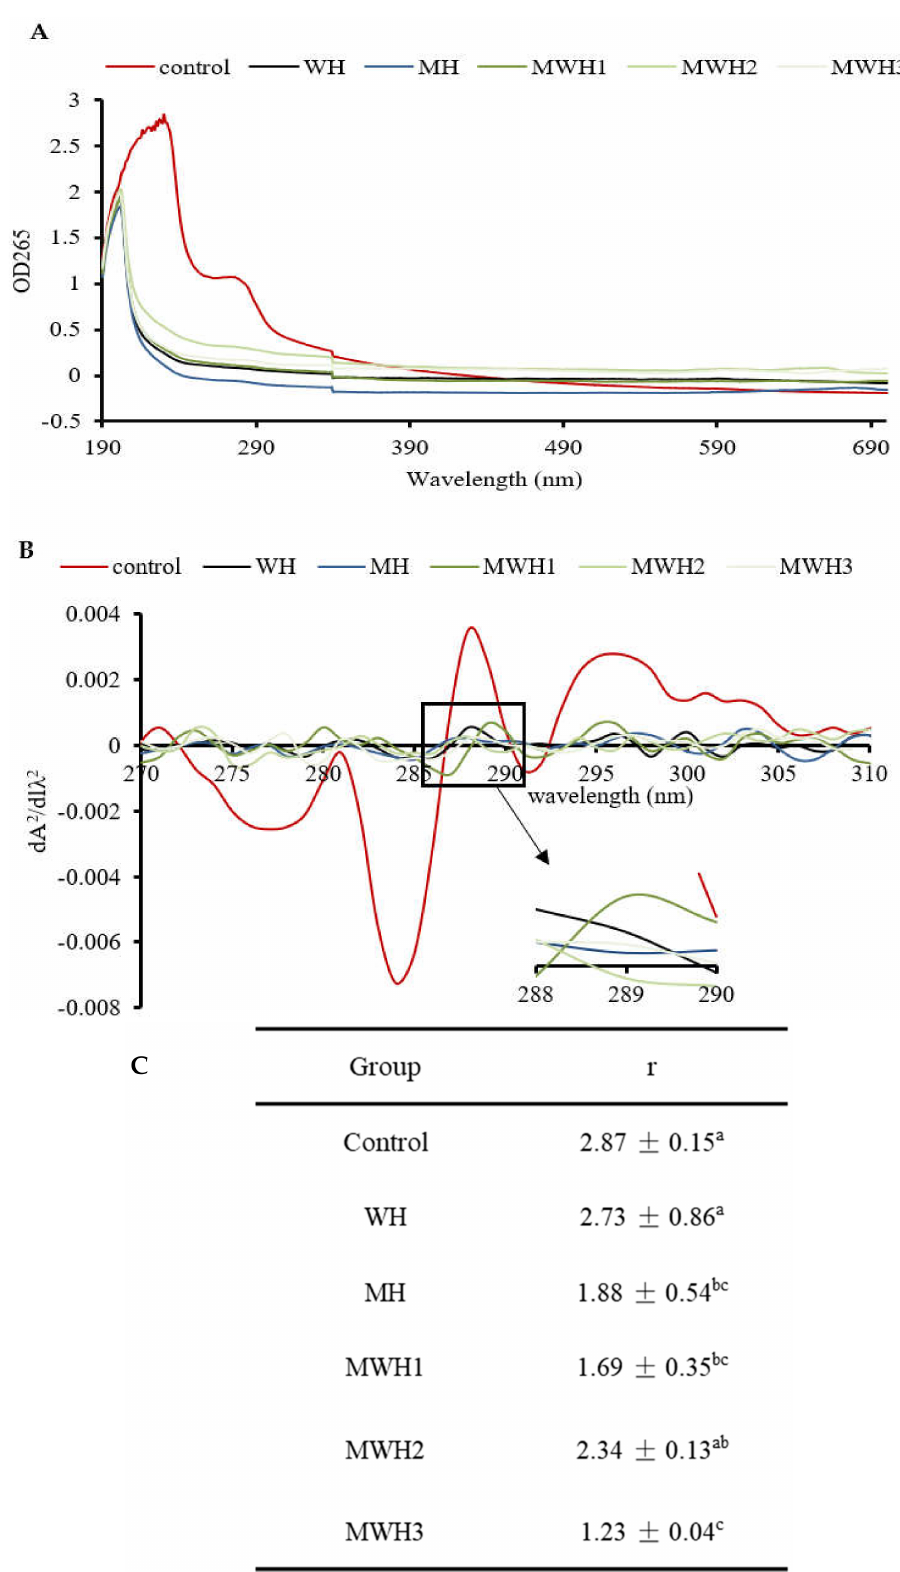
Figure 4. ( A ) The UV absorption spectra of SCM at different heating methods; ( B ) the second derivative spectra of myosin on UV absorption spectra at different heating; ( C ) the ratio of the peak- to-trough values for the two main peaks. Values with different lower-case letters are significantly different ( p <